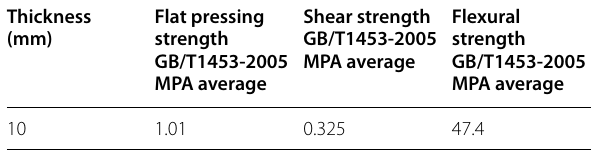
Table 4 Technical data of 3D-fiberglass.